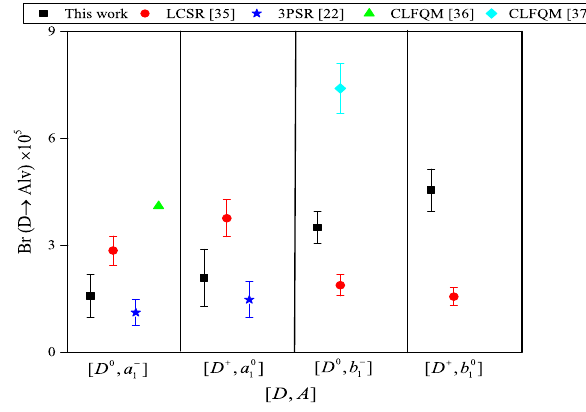
Fig. 6 Our predictions for branching ratio values of the semileptonic ( b − )(cid:2)ν and D + → a 0 ( b 0 )(cid:2)ν decays. The results of the other D 0 → a − 1 1 1 1 methods, estimated using transition form factors, such as LCSR, 3PSR and CLFQM are also reported